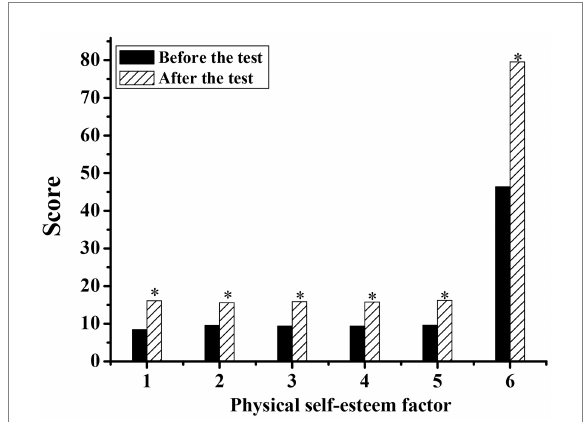
FIGURE 4 Comparison of physical self-esteem scale scores of silver-haired people in the control group before and after the experiment. (1: physical self-worth; 2: athletic ability; 3: physical conditions; 4: physical attraction; 5: physical fitness; 6: total score; * indicates a significant difference compared with before the test, p <